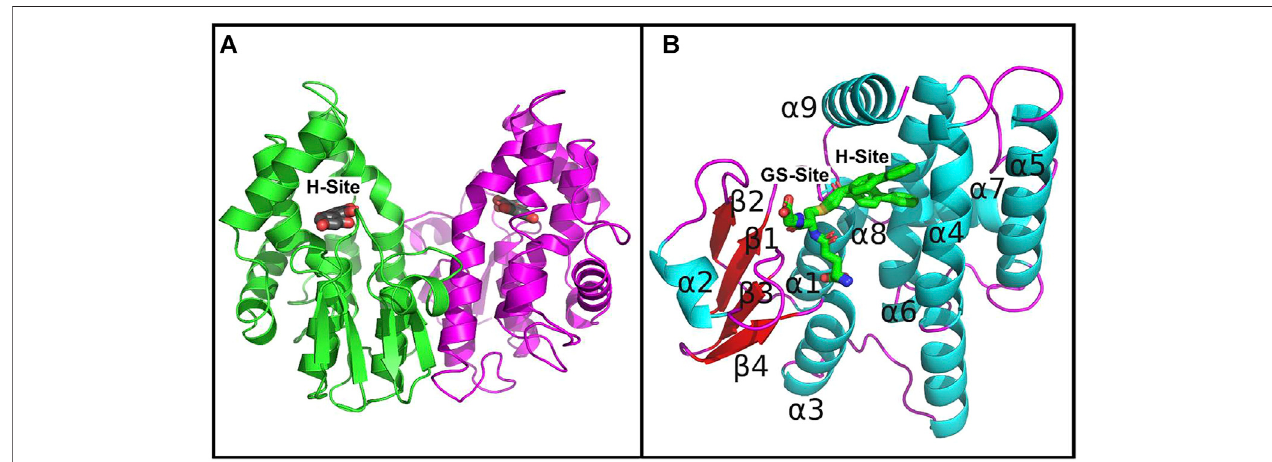
FIGURE 1 | Crystal structures of PtGSTU20. (A) View of the dimer of PtGSTU20 that highlights its putative H-site. The backbone atoms (cartoon) are colored by monomer. The morin fl avonoid is represented as gray sticks with the non-carbon atoms colored according to their types (red, oxygen; blue, nitrogen; yellow, sulfur). (B) View of PtGSTU20 monomer that shows both G- and H-sites. The G-site is occupied by the glutathionyl moiety of glutathionyl-phenylacetophenone (GS-PAP). The phenylacetophenonemoiety,disorderedovertwopositions,de fi nestheboundariesoftheputativeH-site.Thebackboneatoms(cartoon)ofPtGSTU20arecolored according to their secondary structure (cyan, helix; red, strand; magenta, loop). GS-PAP is represented as gray sticks with the non-carbon atoms colored according to their types (red, oxygen; blue, nitrogen; yellow,